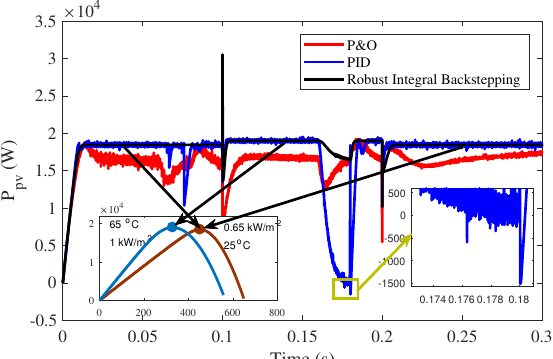
Figure 27. Output power of PV array with multiple faults under varying temperature and